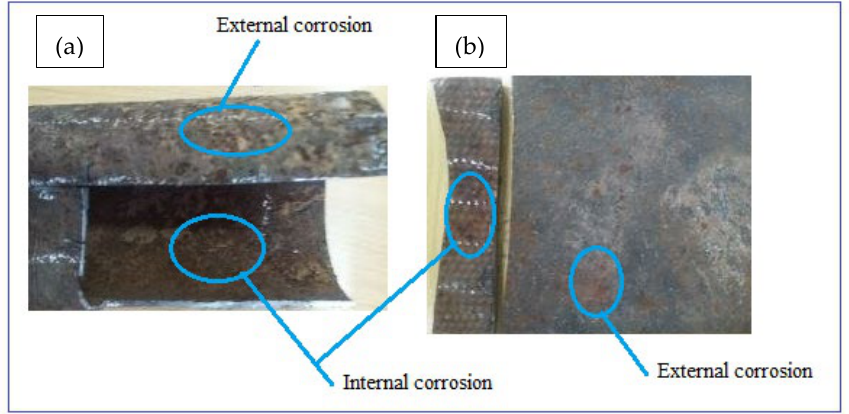
Figure 2. Photographs of typical corrosion damaged surfaces: ( a ) GS pipe and ( b ) DIP pipe.